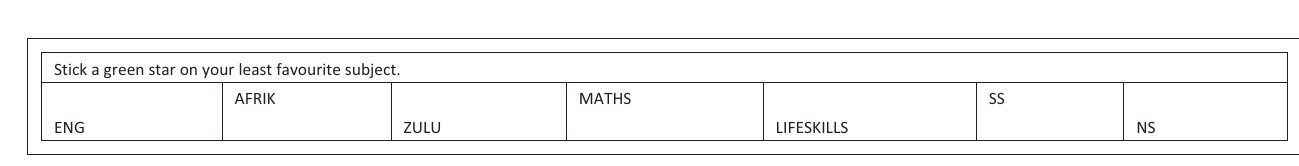
FIGURE 6: Question with subject options.